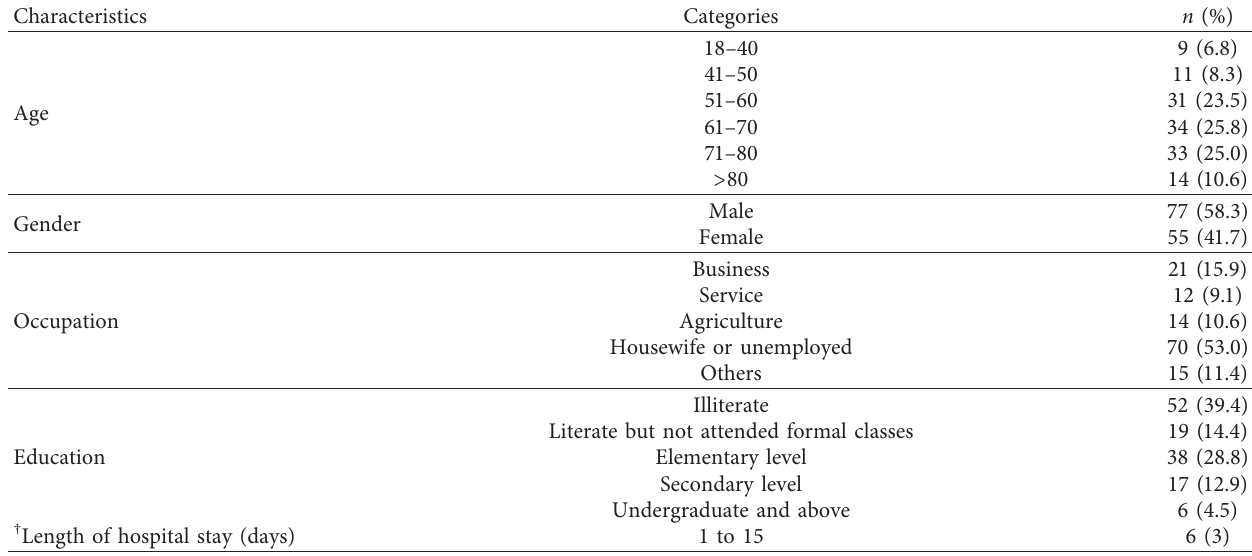
Table 1: Sociodemographic characteristics of patients ( n �